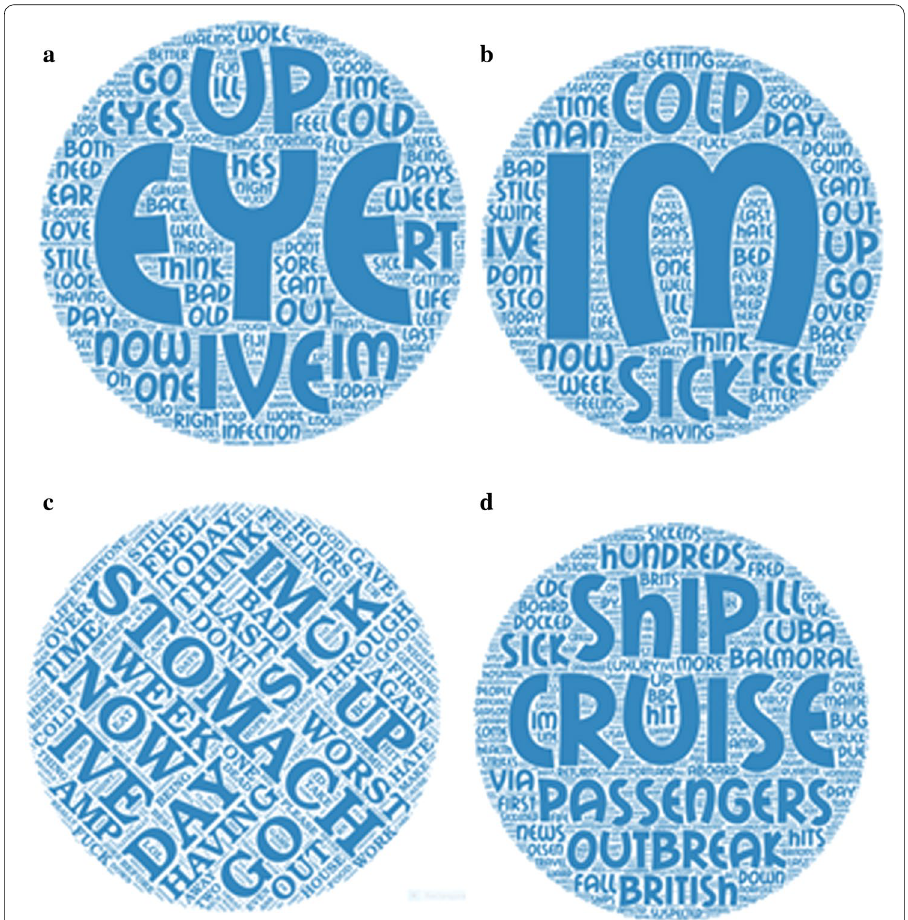
Fig. 1 Empirical word frequencies for context words for different diseases names: a conjunctivitis, b flu common cold, c gastroenteritis, d +